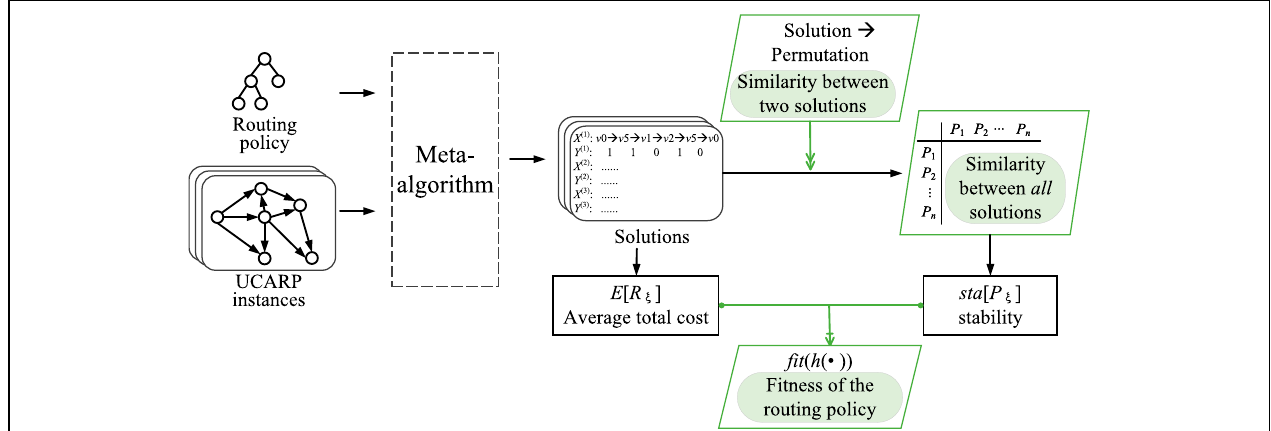
FIGURE 2 | Overview of the proposed method. Given a sampled UCARP instance and routing policy, the meta-algorithm (Liu et al., 2017) can be used to generate a feasible solution. The proposed method revises the fitness function by considering the total cost and the stability simultaneously. To this end, we first propose a way to measure the similarity between two solutions, then extend it for evaluating the similarity between all solutions, which can be utilized to measure the stability of a routing policy.